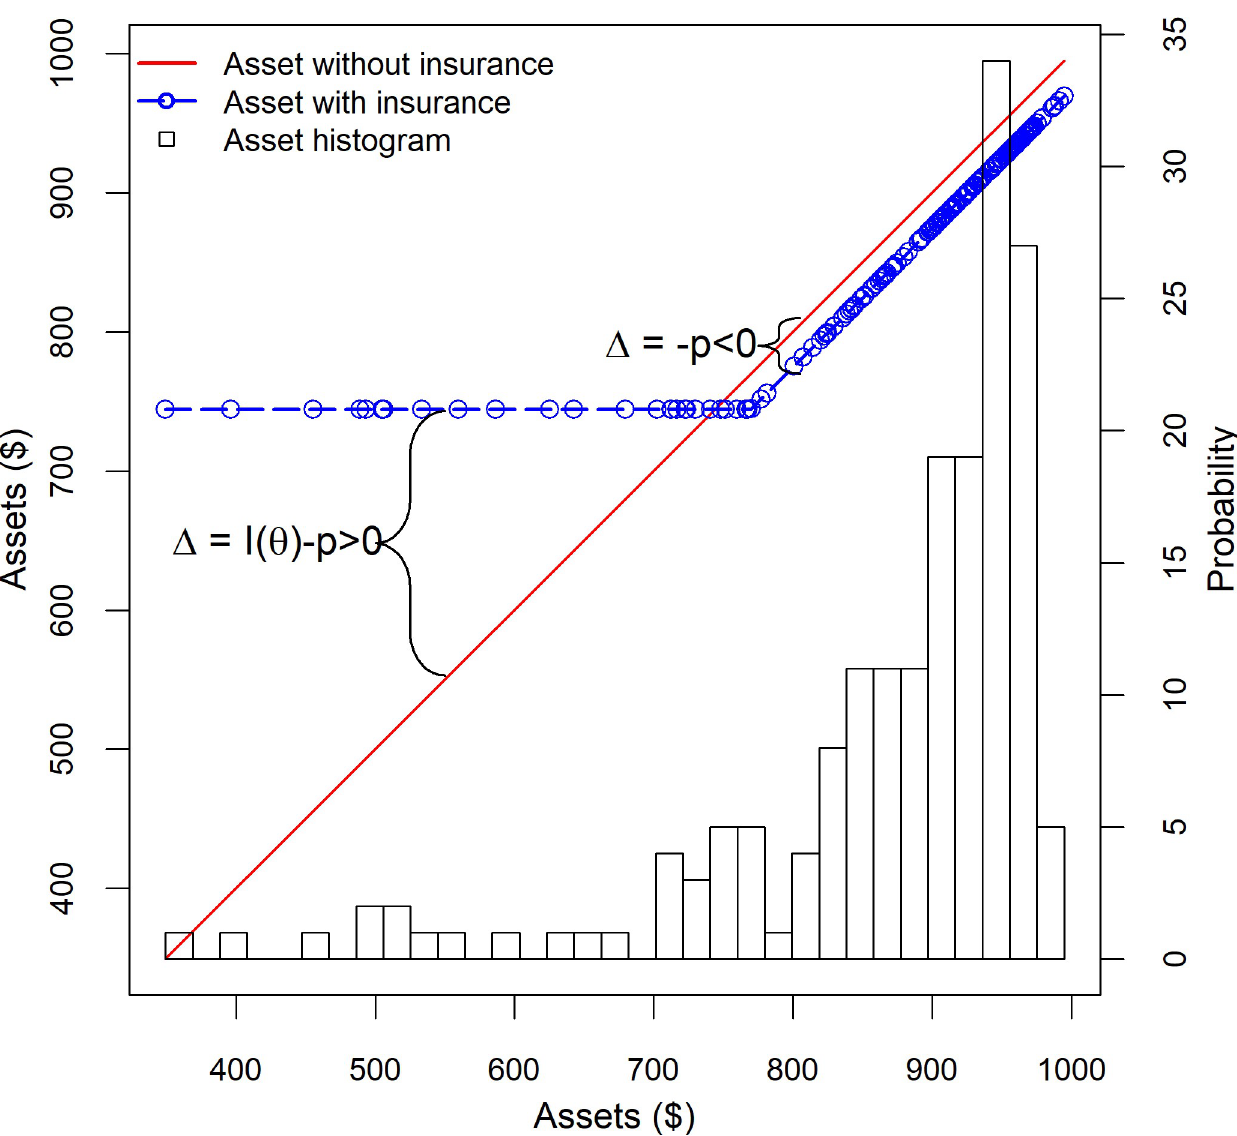
Fig 1. Histogram showing livestock mortality in different asset bins, household livestock assets without insurance, and assets with a perfect insurance contract. Each observation is a random draw from an underlying risk distribution for a household with about 1 tropical livestock unit expressed in US dollars ($); in this simplified example we only consider mortality, not herd growth through birth. See text for a description of the equations.